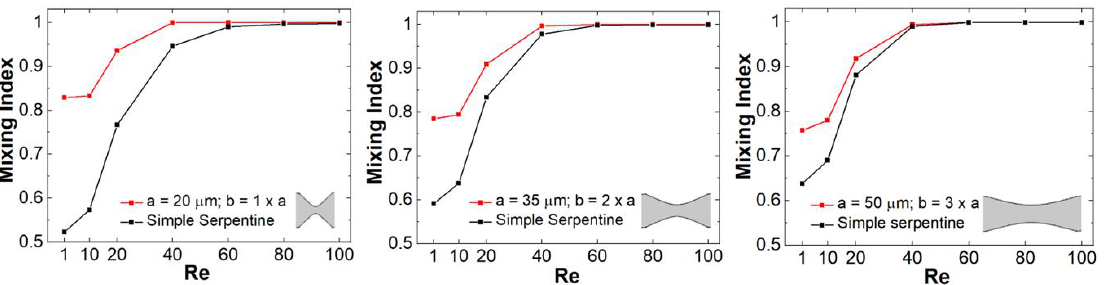
Figure 5. Velocity magnitude and concentration maps for the ( a ) design with a = 50 μ m and b = 3 × a ; and ( b ) the corresponding simple serpentine channel ( Re = 20).